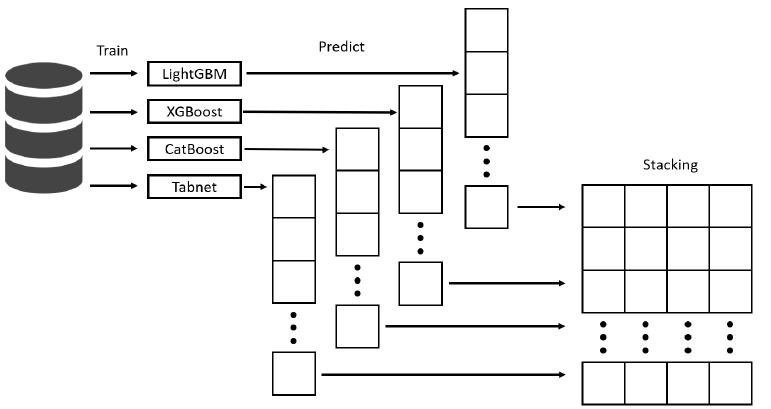
Figure 4. Summary graph for the first step of the stacking method: training dataset of metamodels is generated by machine learning models and a deep learning model in this step.